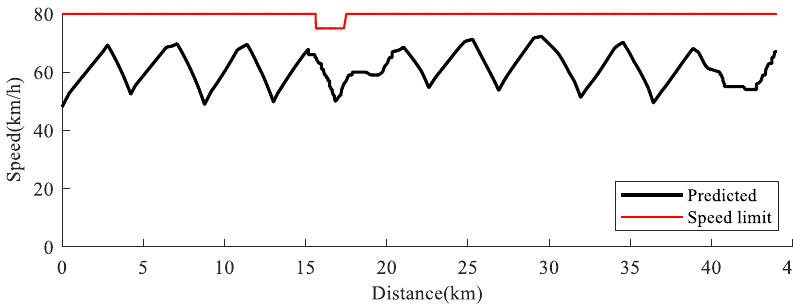
Figure 11. Scenario 2: train operation curve under predicted control strategy.